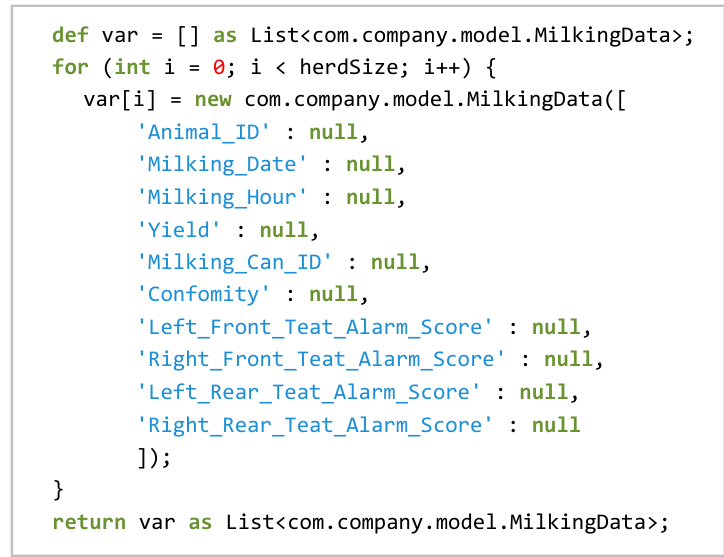
Figure 17. Activity diagram of a business process used to record milking data after each milking session. In detail, the diagram shows the collaboration between different software components during the execution of the process “Scheduled Recordings”.